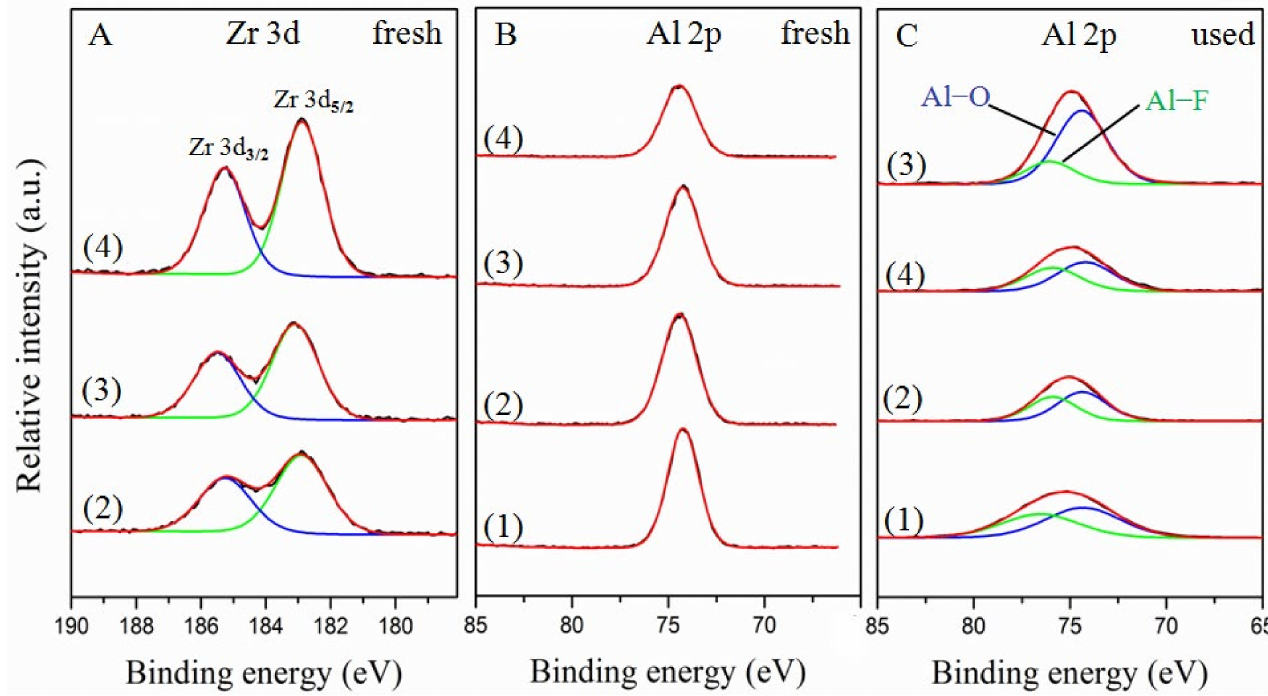
Figure 10. X-ray photo electron spectroscopy (XPS) spectra of catalyst, ( A ) : Zr 3d of fresh, ( B ): Al 2p of fresh and ( C ) : Al 2p of used. ( 1 ) γ -Al 2 O 3 , ( 2 ) 9% Zr/ γ -Al 2 O 3 , ( 3 ) 16% Zr/ γ -Al 2 O 3 and ( 4 ) 35% Zr/ γ -Al 2 O 3